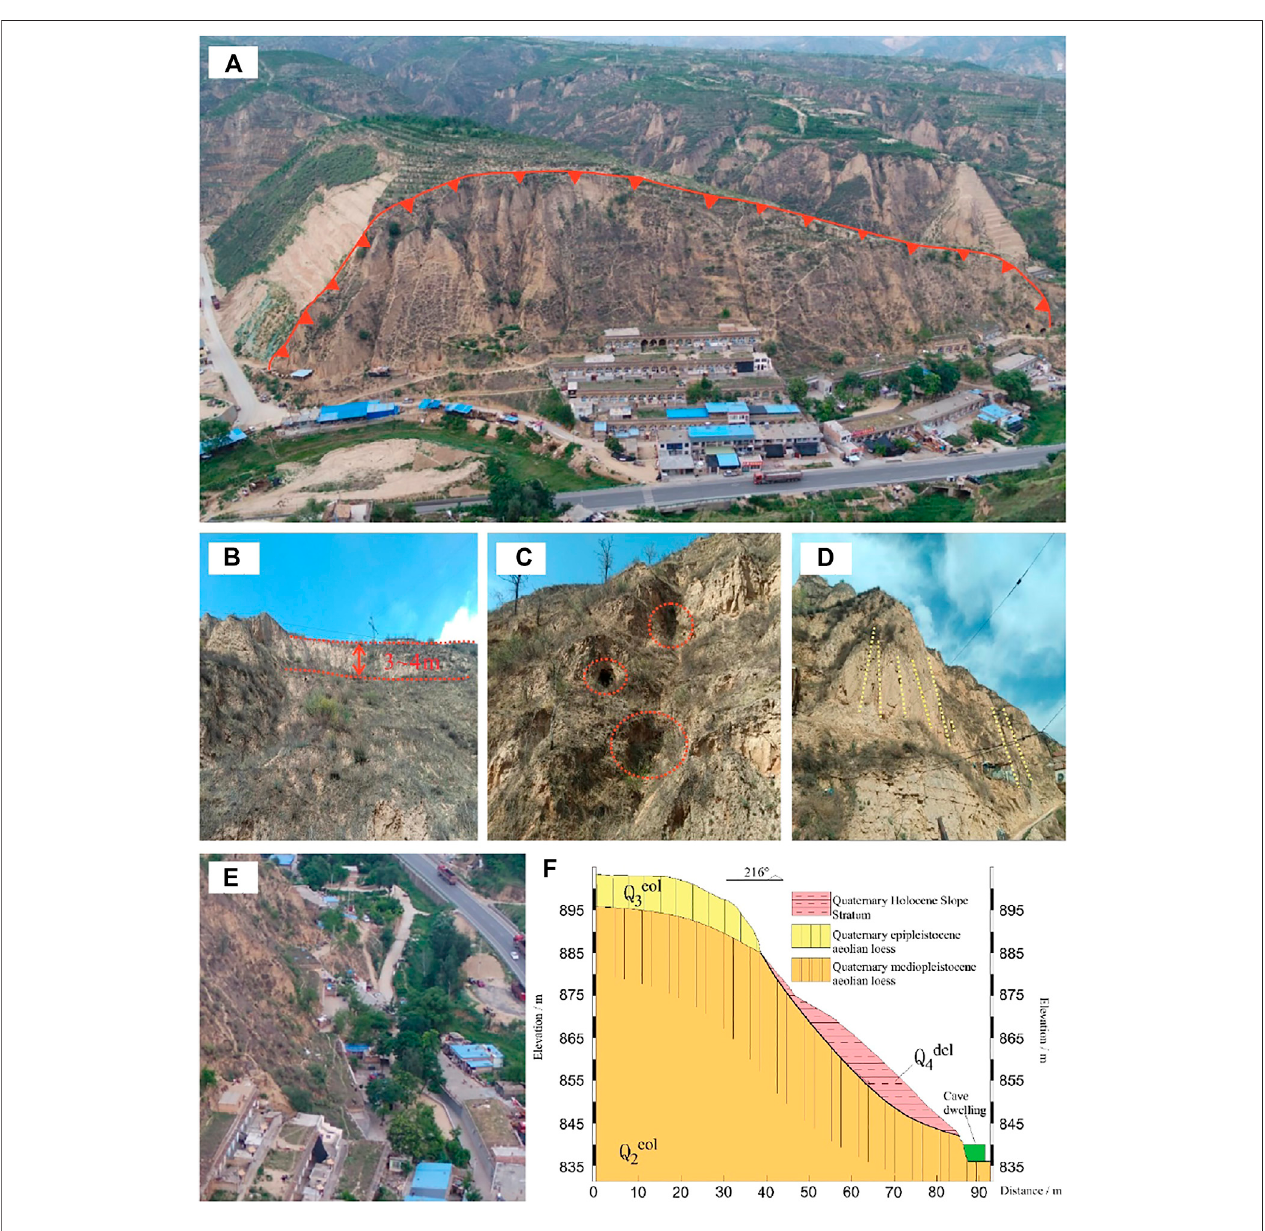
FIGURE2| Filed investigation on Tianshuigou landslide. (A) Landslide boundary; (B) Scarps ontheback edge ofthelandslide; (C) Slope gullies and sinkholes; (D) Well-developed vertical joints; (E) Steep toe at the front of the landslide; (F) Main pro fi le of landslide showing stratums.